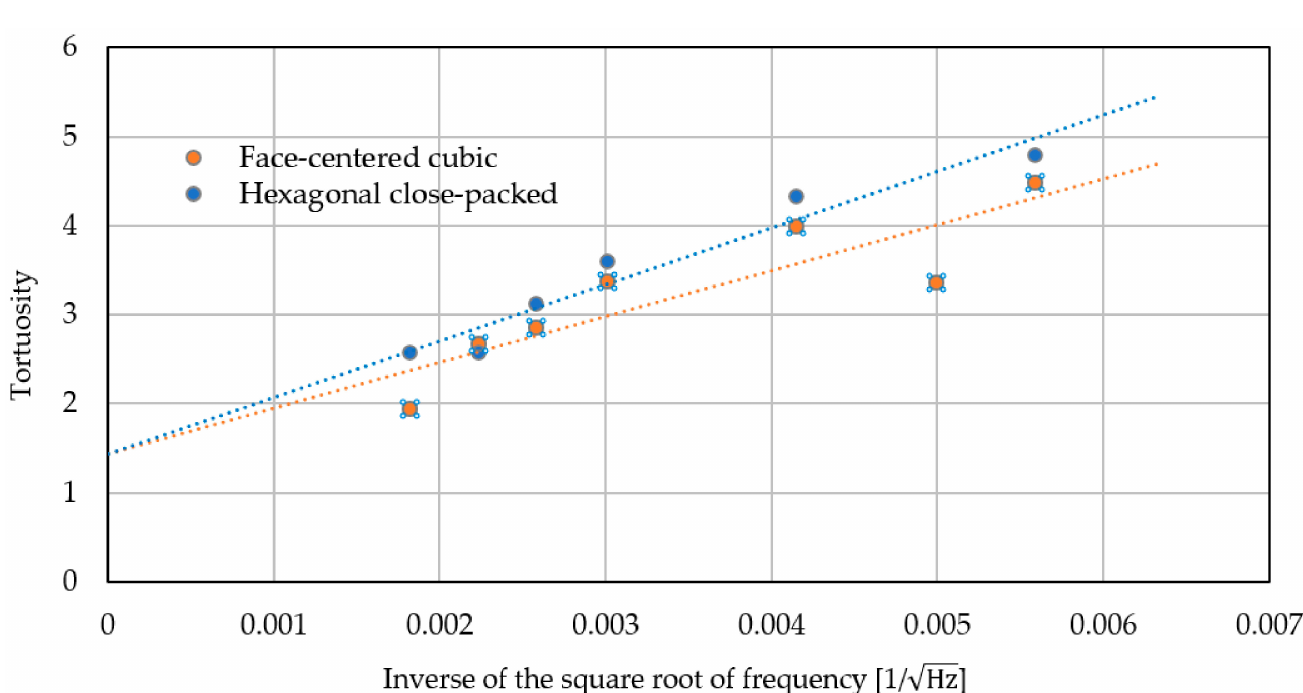
Figure 4. Measurement results of the